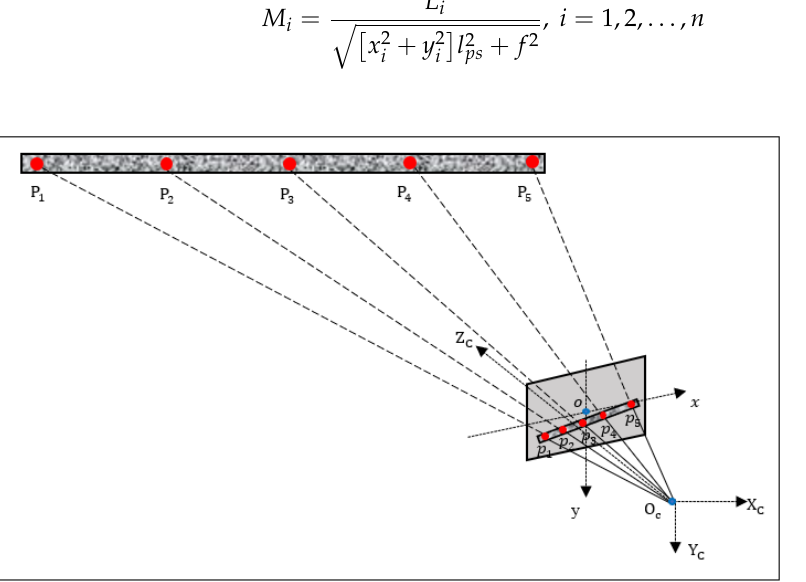
Figure 4. Schematic of the full-field scale factor determination, where 𝑃 1 , 𝑃 2 , … , 𝑃 5 are the points whose distances to the camera have been measured, and 𝑝 1 , 𝑝 2 ,… , 𝑝 5 are the corresponding pixels in the captured image.